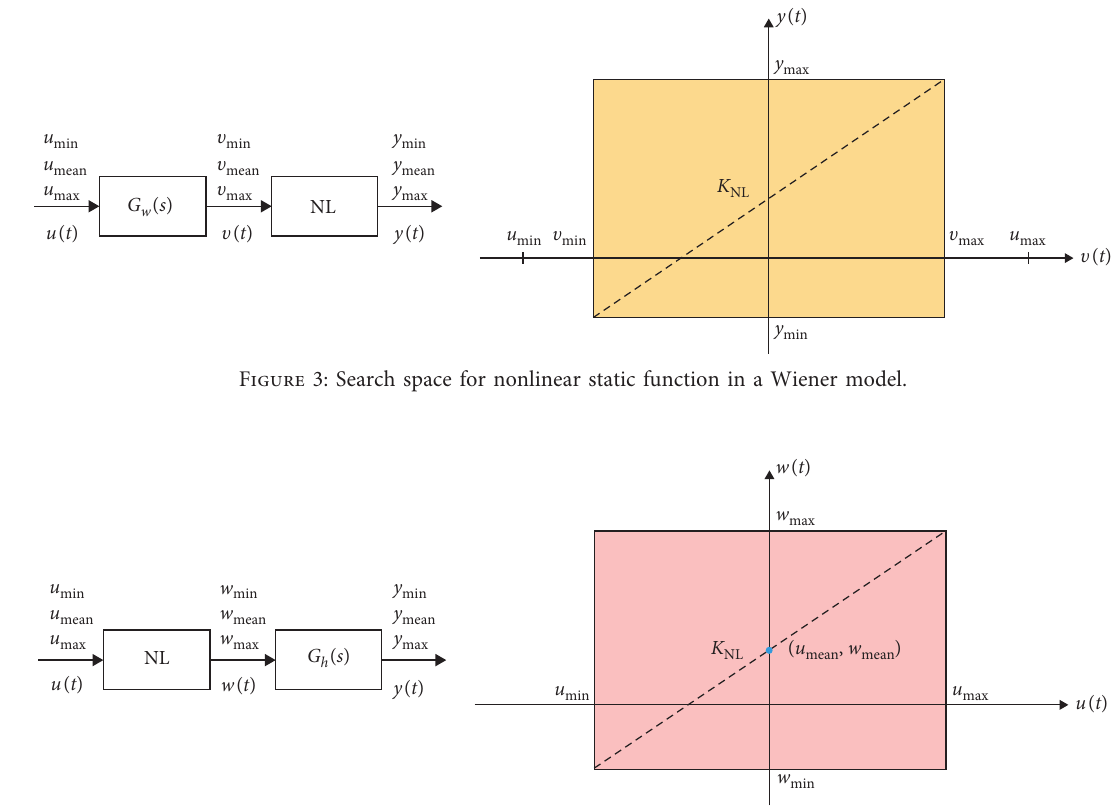
Figure 4: Search space for nonlinear static function in a Hammerstein